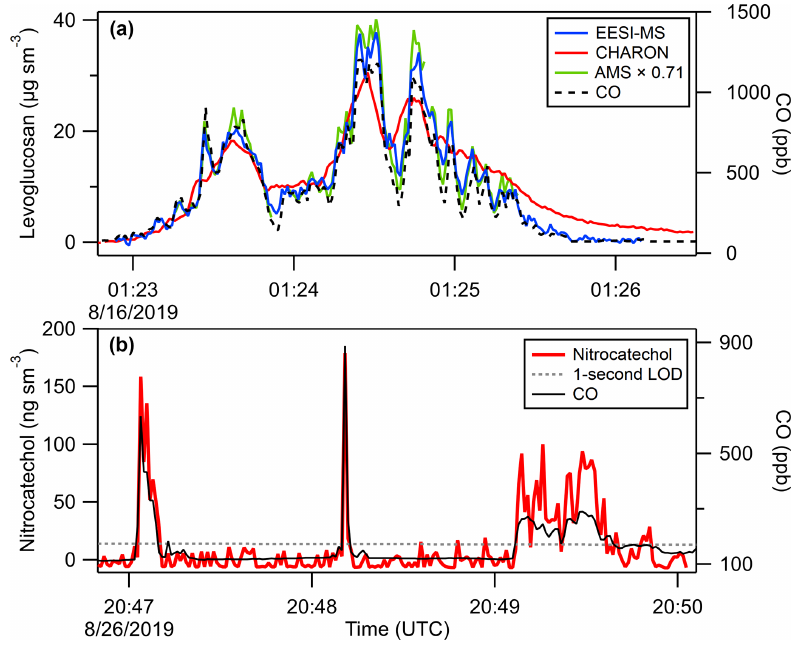
Figure 5. Example 1Hz (a) EESI( + ) levoglucosan and (b) EESI( − ) nitrocatechol time series from measurements of wildfire smoke aerosol, including comparison to CHARON PTR-MS and AMS (scaled by a factor of 0.71 to show temporal agreement). Carbon monoxide measure- ments are included to show the boundaries and structure of the smoke